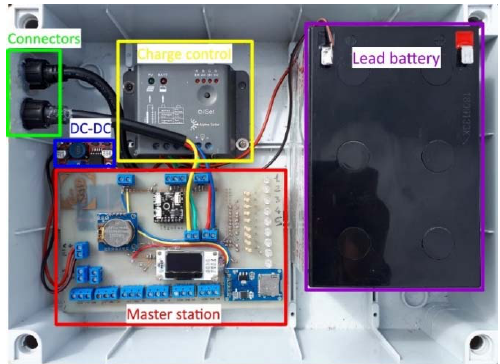
Figure 8. Master station and power supply mounted within the waterproof box. Waterproof connectors for measuring unit and solar panel connection are visible.